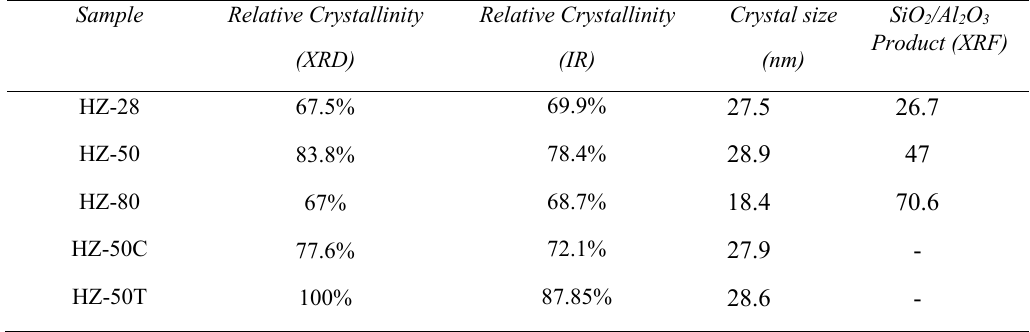
Table 2. The relative crystallinity & crystal size of zeolites (Chemical composition of the starting materials for the synthesis of zeolites determined by